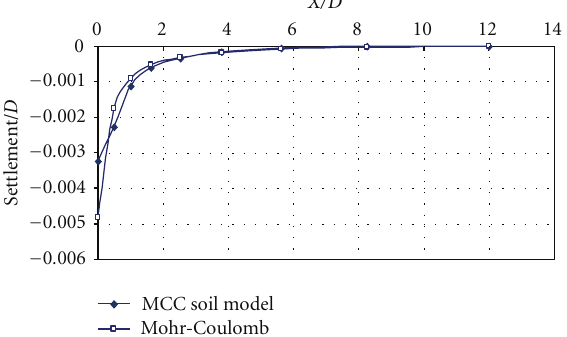
Figure 6: Vertical movement around the tunnel using Mohr- Coulomb failure criterion for the first layer.